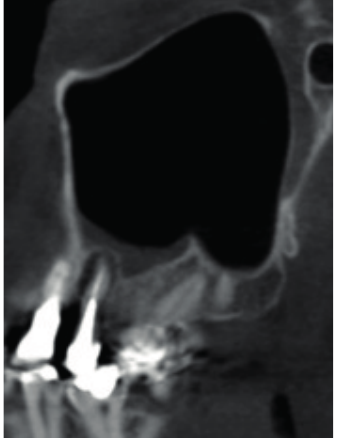
Figure 2. Periapical